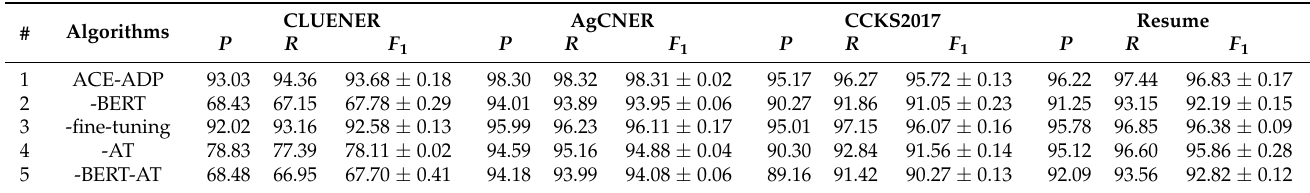
Table 4. Recognition results of ACE-ADP and its variants on four